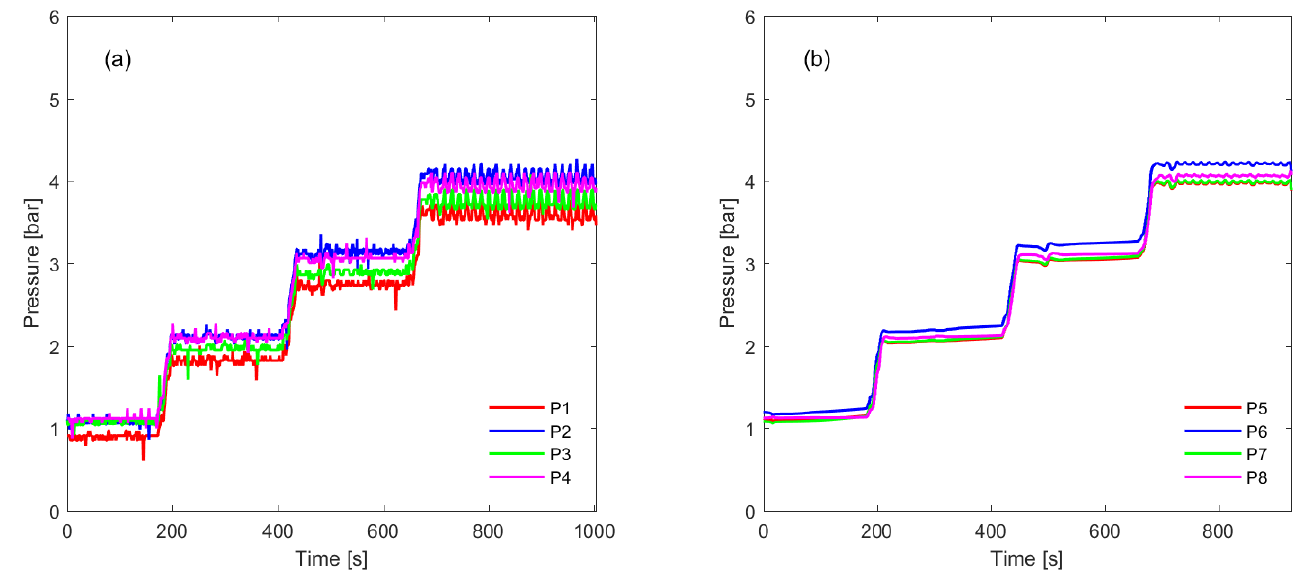
Figure 8. Data acquired during hydrodynamic tests. Panels: ( a ) Arduino, ( b ) SCADA. Figure 8 compares the pressure values recorded, confirming that Arduino system has a much higher data acquisition frequency than SCADA. In order to further validate the proposed system, the experimental data were compared with the results of theoretical equations. In Figure 9, the comparison between the mathematical formulation data (dashed lines) and experimental (symbols) piezometric line is